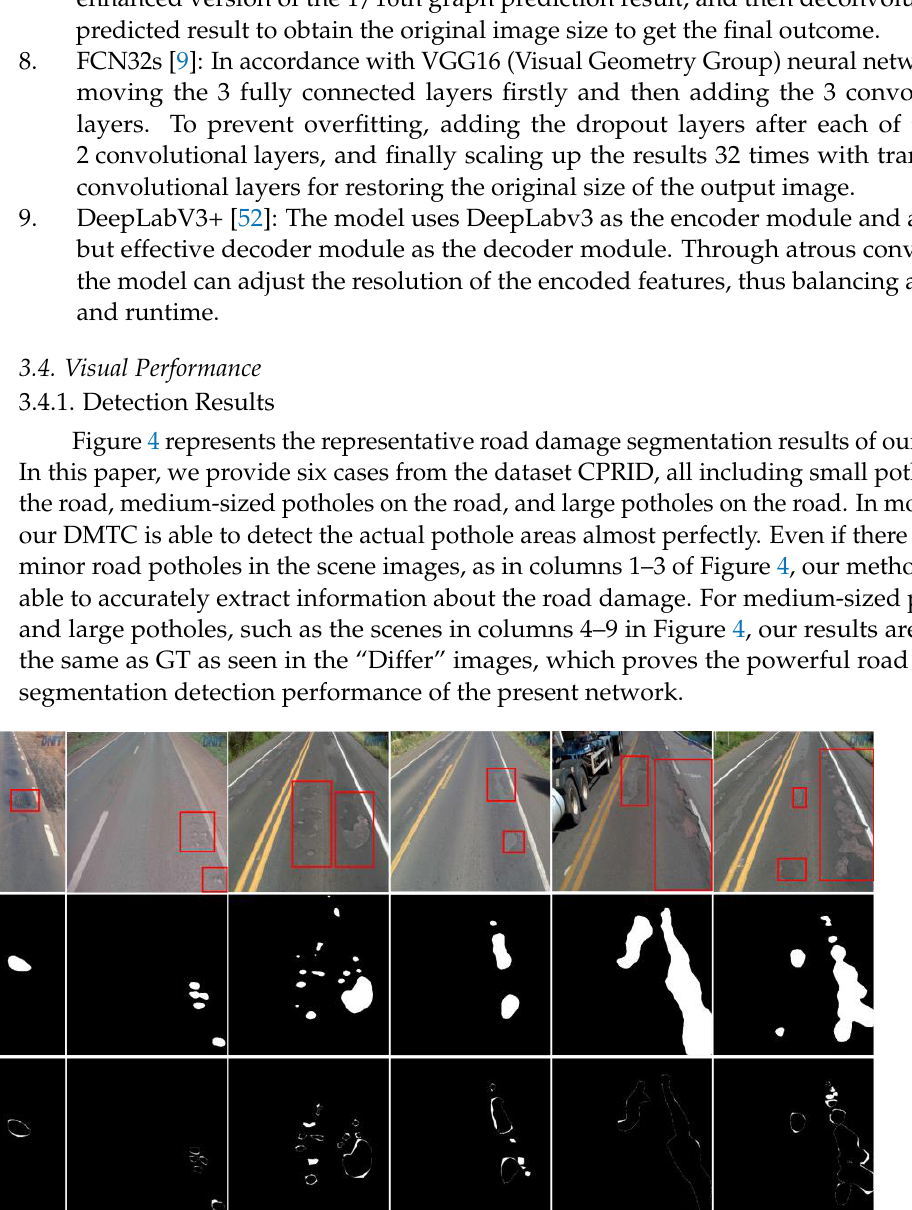
Figure 5. Visual comparison of the results of a series of segmentation methods for small potholes on CPRID. There is a red outline around the pits in the original image, a white outline around the pits in the label map and segmentation map, and black in the rest of the background.